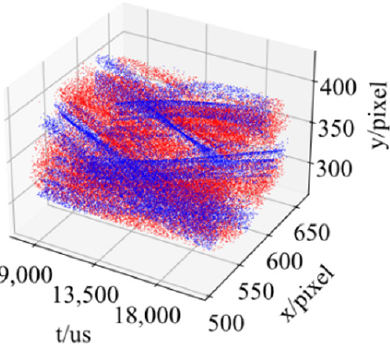
Figure 1. Illustration of event stream, where blue points represent positive-polarity events, and red points represent negative-polarity events.